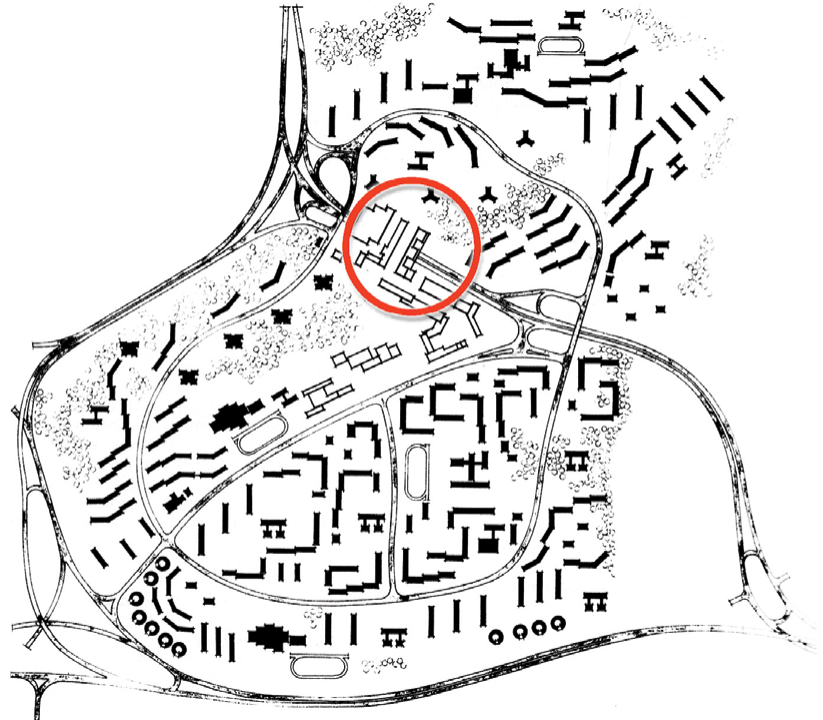
Fig. 1. Project of